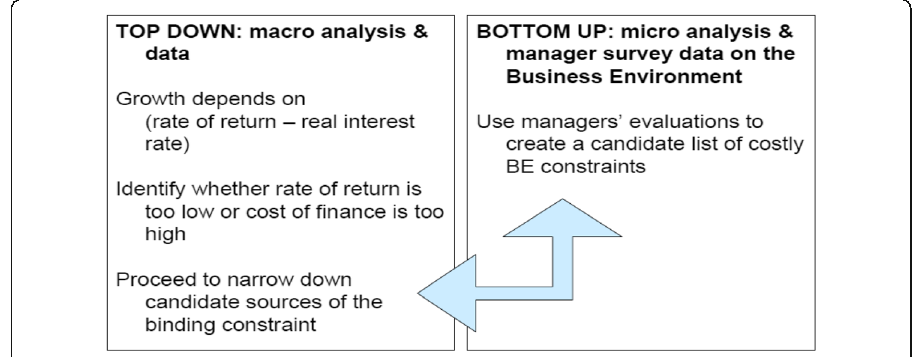
Fig. 2 Diagnosing binding constraint combining growth diagnostics with manager survey data. Source: Adapted from Carlin and Seabright